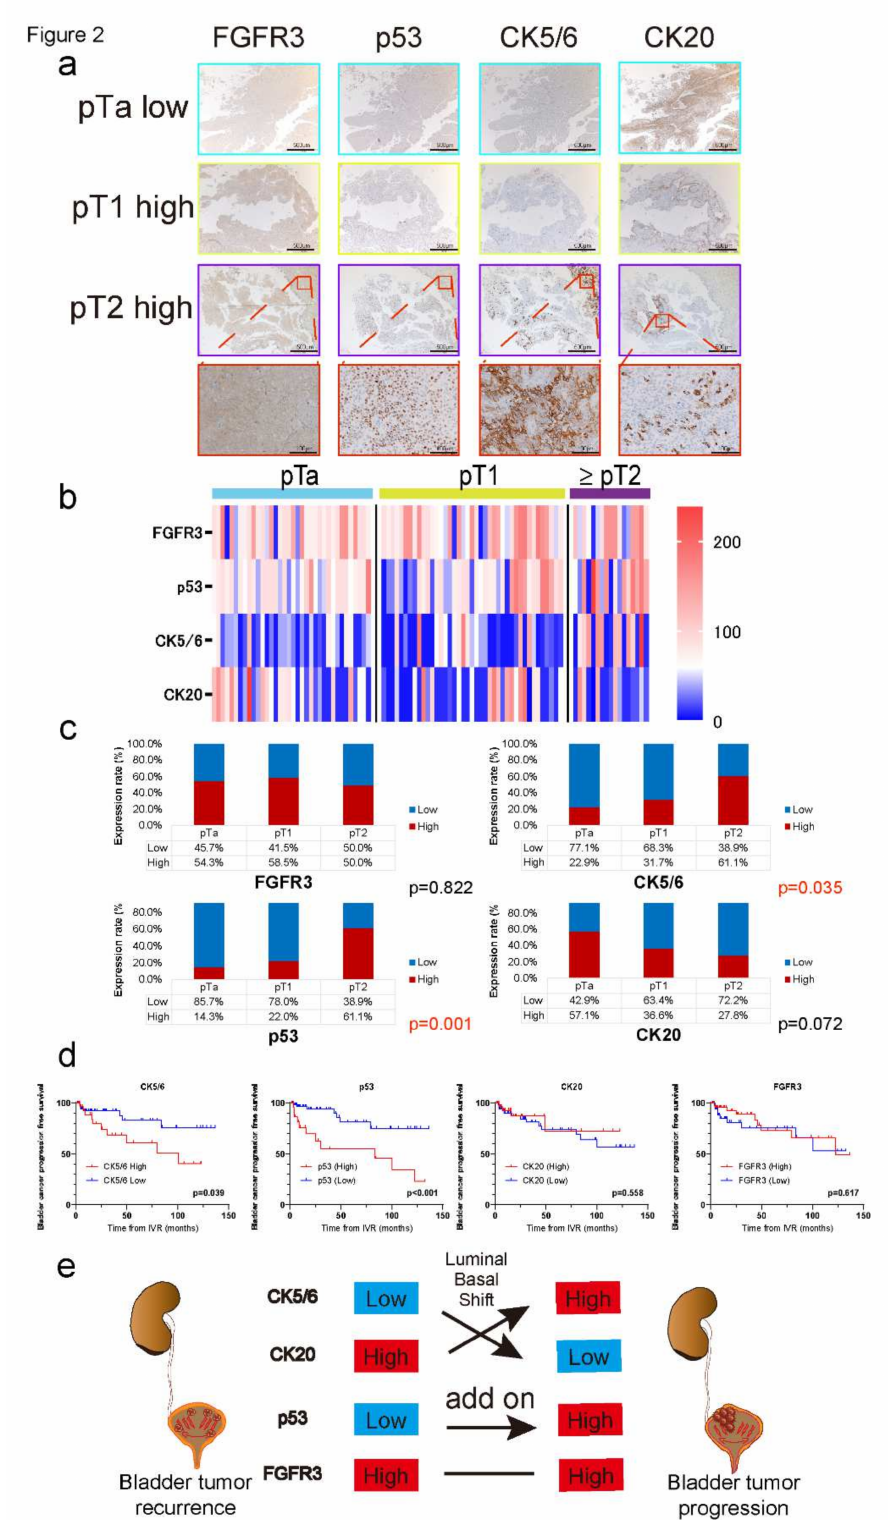
Figure 2. ( a ) Representative IHC staining of FGFR3, p53, CK5/6, and CK20 in surgical specimens after transurethral resection of bladder tumor (TURBT); pTa low-grade IVR specimen, pT1 high-grade IVR specimen, and pT2 high-grade IVR specimen are shown, respectively. Low-power field scale bar = 500 µ m, and high-power field scale bar = 100 µ m. ( b ) Heatmap describing the IHC score of FGFR3, p53, CK5/6, and CK20 in transurethral resection (TUR) specimens after IVR ( n = 94). Heatmap